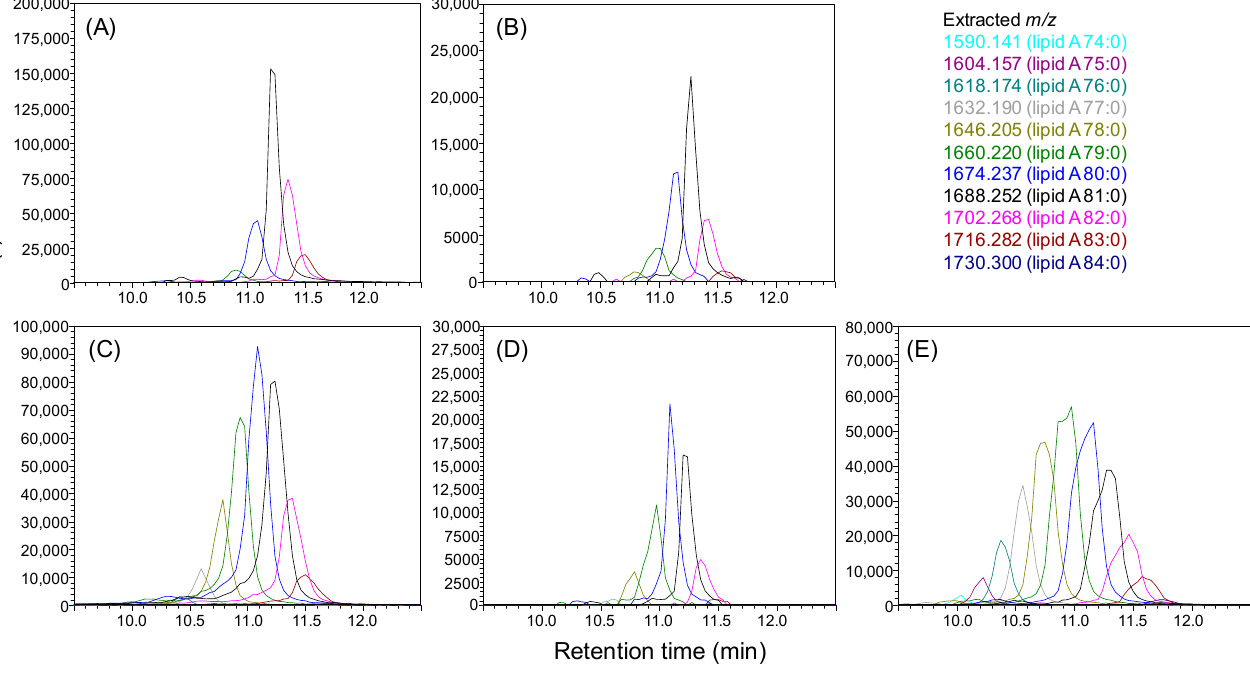
Figure 4. Lipid A in Bacteroidetes strains. Extracted-ion chromatograms of lipid A obtained from ( A ) B. fragilis , ( B ) B. thetaiotaomicron , ( C ) B. vulgatus , ( D ) O. laneus , and ( E ) P. copri. MS1 spectra of lipid A extracts of all Bacteroidetes were presented in Figure S4.